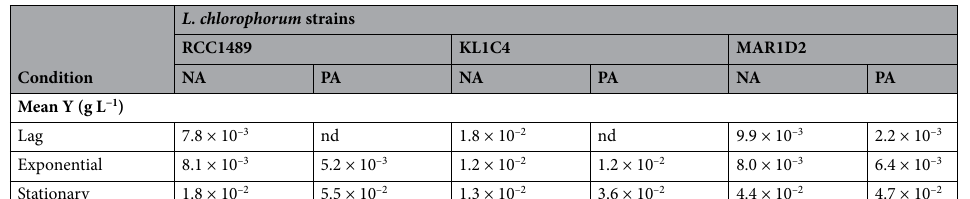
L. chlorophorum strains